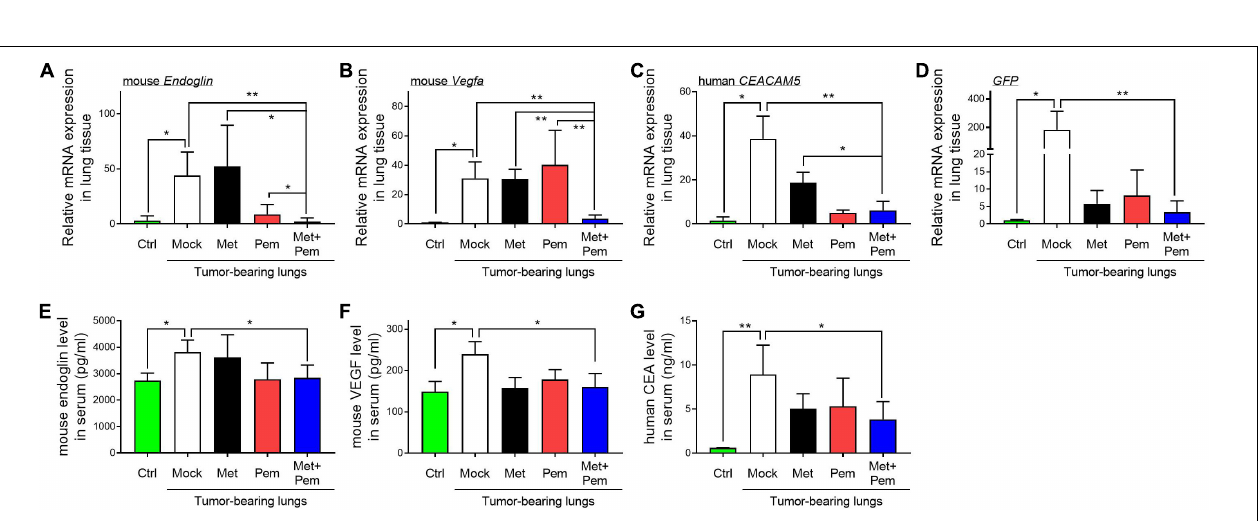
FIGURE 7 | Molecule expression related to the metformin/pemetrexed additive inhibitory effects on pulmonary tumorigenesis and angiogenesis in a human orthotopic NSCLC xenograft model. RT-qPCR was performed to analyze the expression of angiogenic indicators (A) Endoglin and (B) Vegfa , tumor marker (C) carcinoembryonic antigen ( CEACAM5 ), and (D) GFP in the lung tissues of mice that received different treatments. Values were normalized to GAPDH levels and are expressed relative to the control group. The expression levels of (E) Endoglin, (F) VEGF and (G) human CEA in the serum of the mice were determined using ELISA kits. The data are presented as the mean ± SD of those from 2–3 independent experiments with two technical replicates in each. * P < 0.05 and ** P < 0.01.